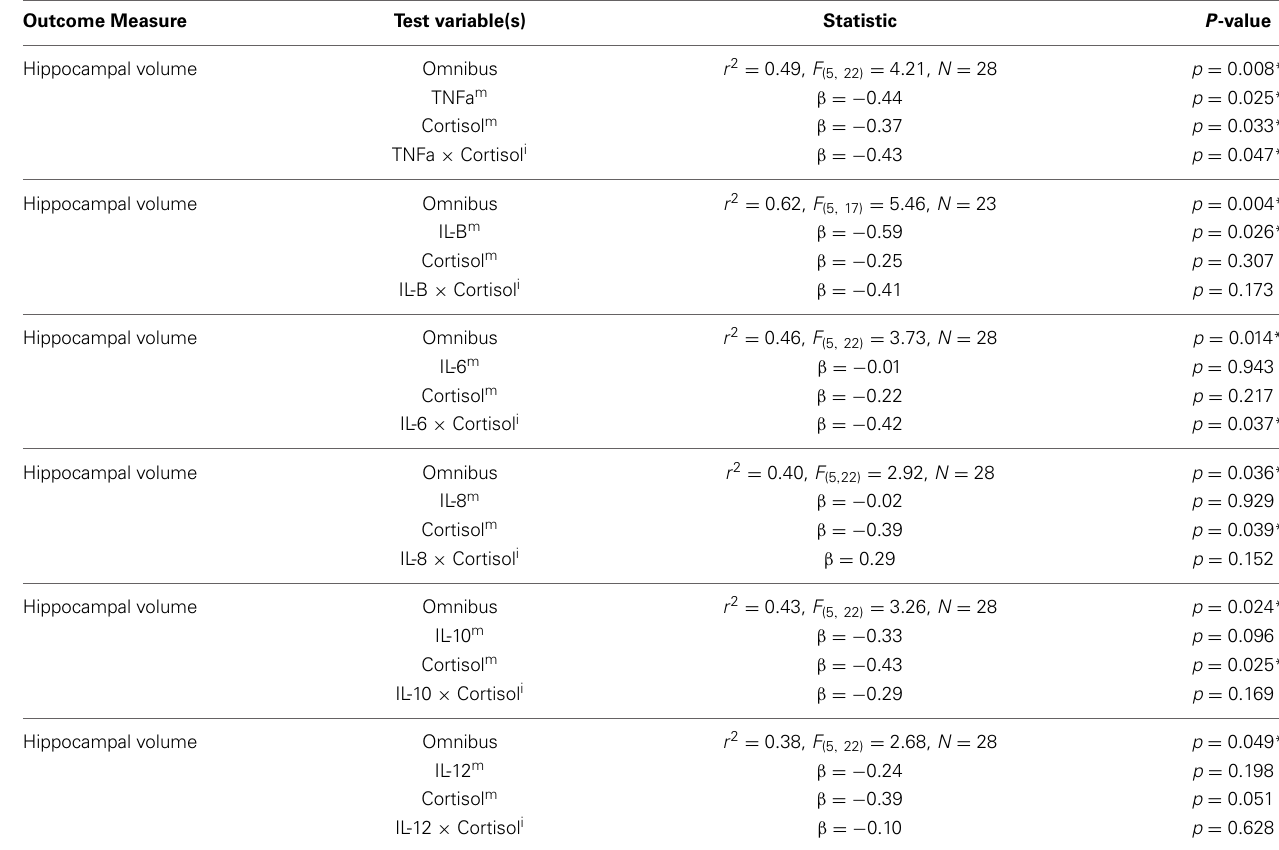
Table 1 | The effects and interactions of various cytokines and cortisol levels on hippocampal volume (corrected for total intracranial volume). Outcome Measure Test